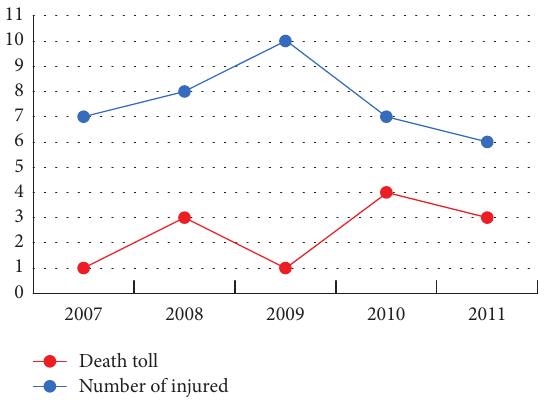
Figure 1: Roof falling accident of a group enterprise from 2007 to